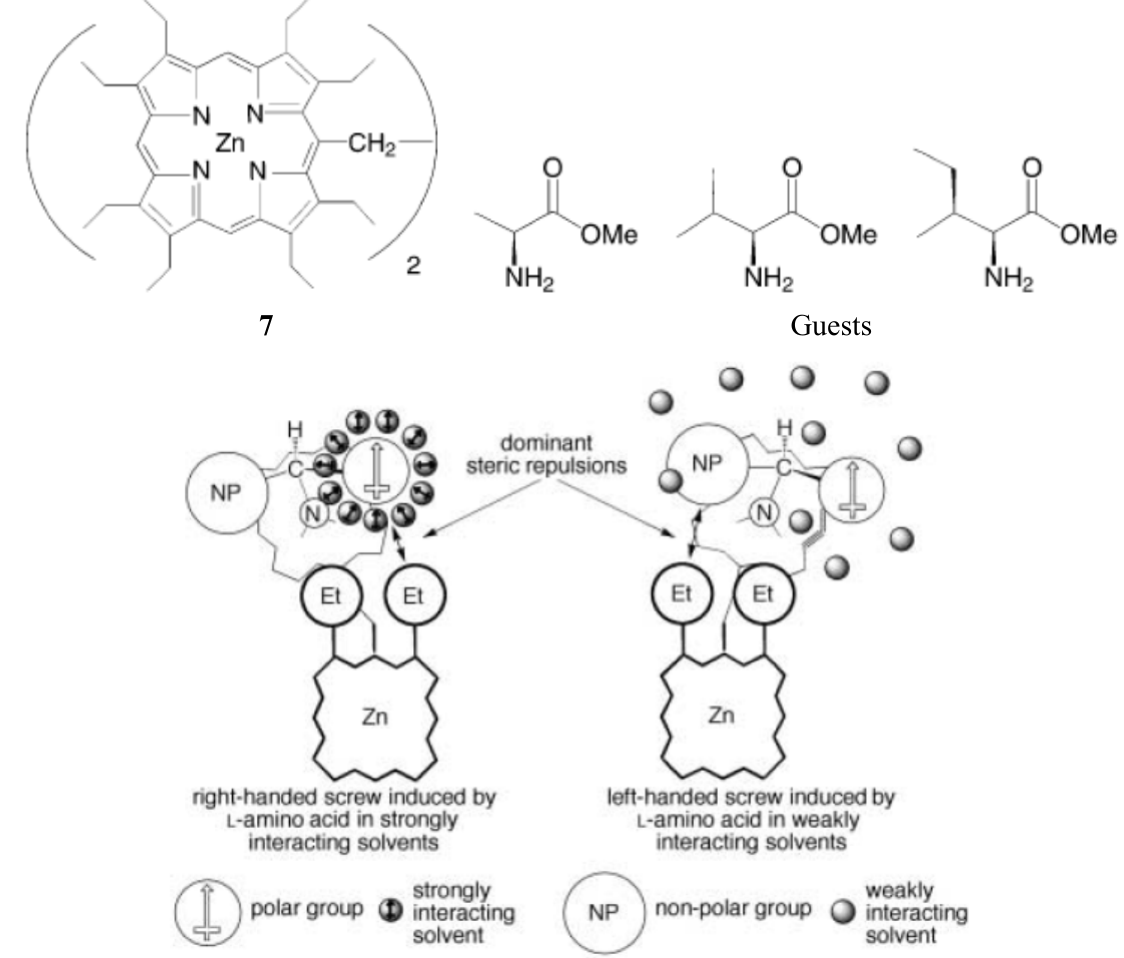
Figure 12. Solvent effect on the mechanism of supramolecular chirality induction in complexes between a zinc porphyrin scissor ( 7 , top left) and amino acid derivatives (top right), in strongly and weakly interacting solvents (the ligand coordinated to the upper porphyrin has been omitted for clarity) [64]. Reproduced by permission of